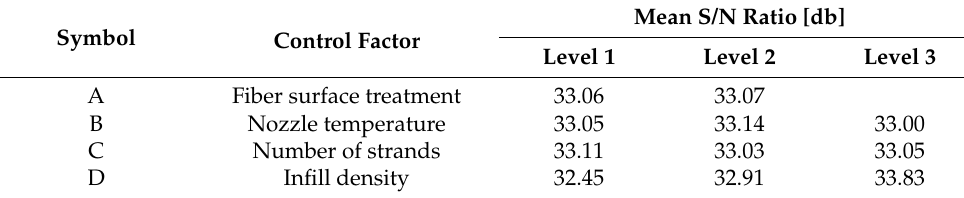
Table 6. Mean response table of S/N ratio for tensile strength and significant interaction.